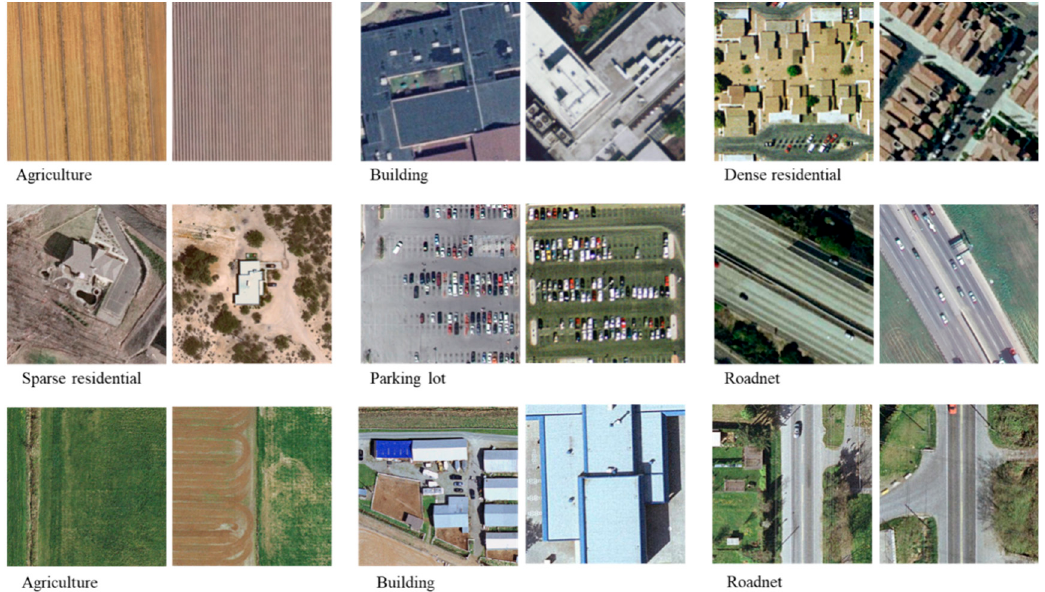
Figure 3. Example images used for training the models—the UC-Merced dataset (the first two rows) and the manually extracted samples (the third row).